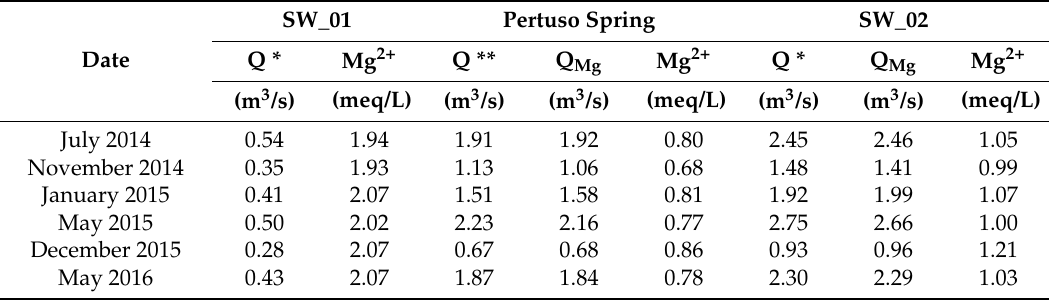
Table 4. Magnesium content and discharge values obtained by current-meter and magnesium tracer method (Q *: discharge values obtained by current-meter method; Q **: discharge values obtained by the difference between the values measured with the current-meter in SW_01 and